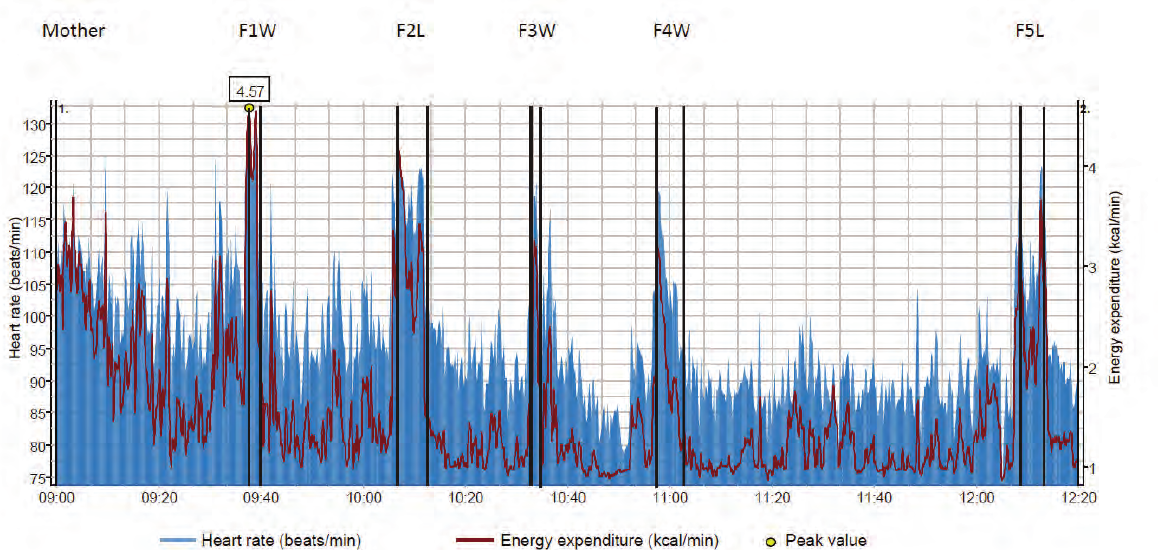
Figure 1. Cardiovascular and energy expenditure patterns of father immediately before, during, and immediately after watching son compete